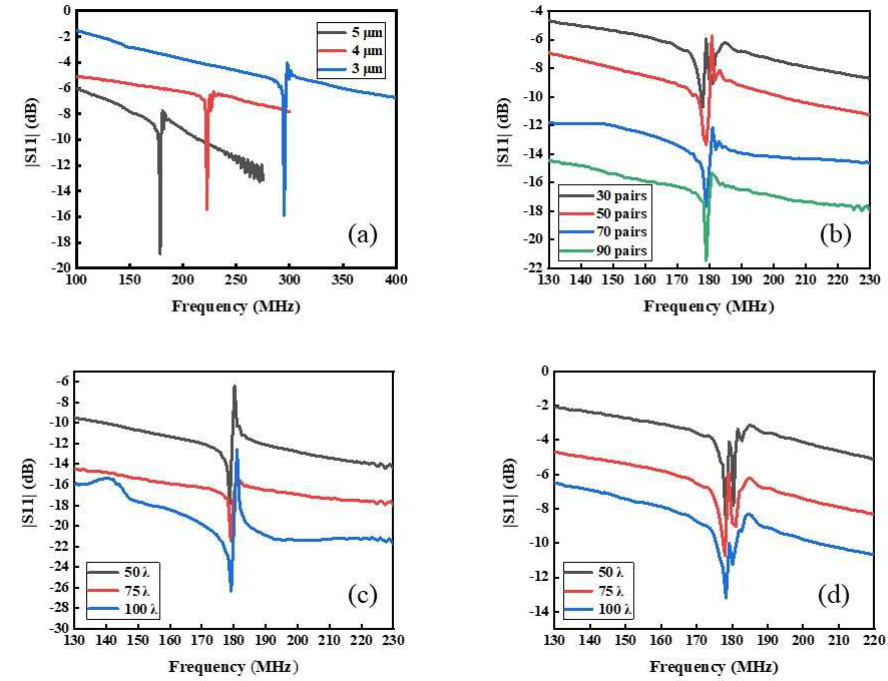
Figure 4. ( a ) Centre frequency of IDT with different λ , ( b ) S11 parameters curves of IDT with different pairs N p . S11 parameters curves of IDT with different acoustic aperture W, ( c ) each of these devices has 50 pairs of IDTs, ( d ) each of these devices has 30 pairs of IDTs. 5 μm